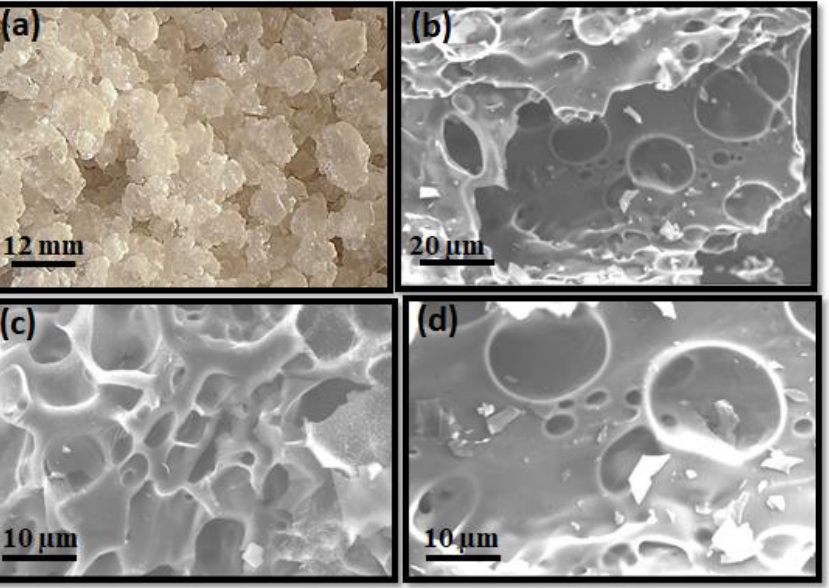
Figure 3. Optical image of water kefir grains ( a ) and SEM images obtained for unwashed water kefir carbons measured at 20 ( b ) and 10 µ m ( c , d ).